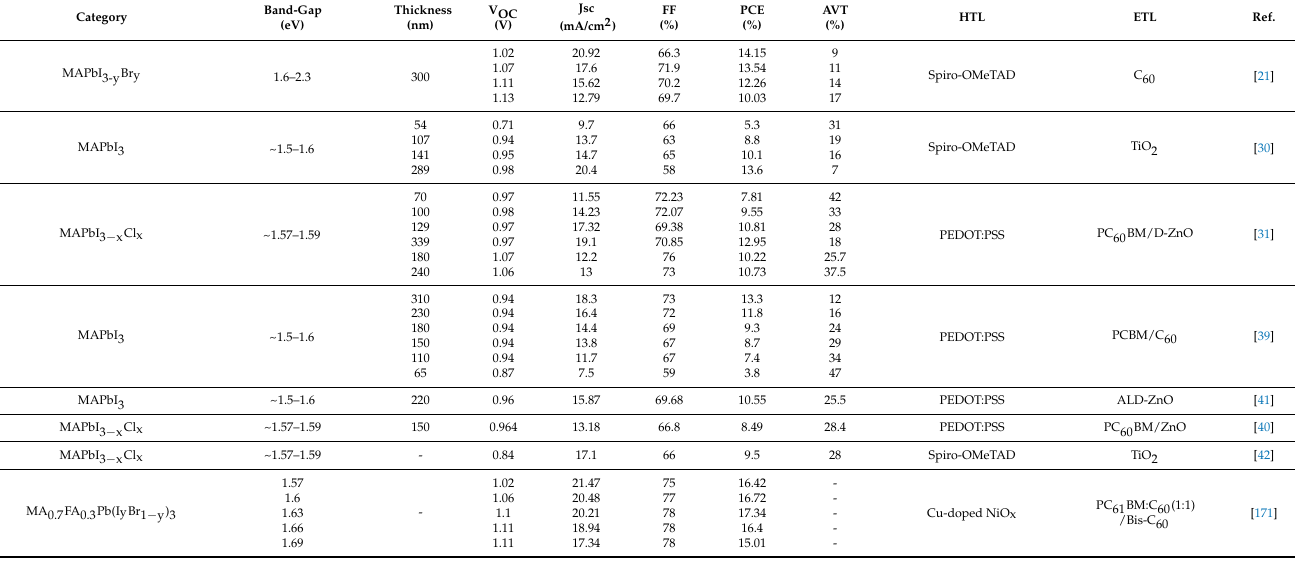
Table 1. Summary of representative ST-PSCs with different perovskites and charge transport